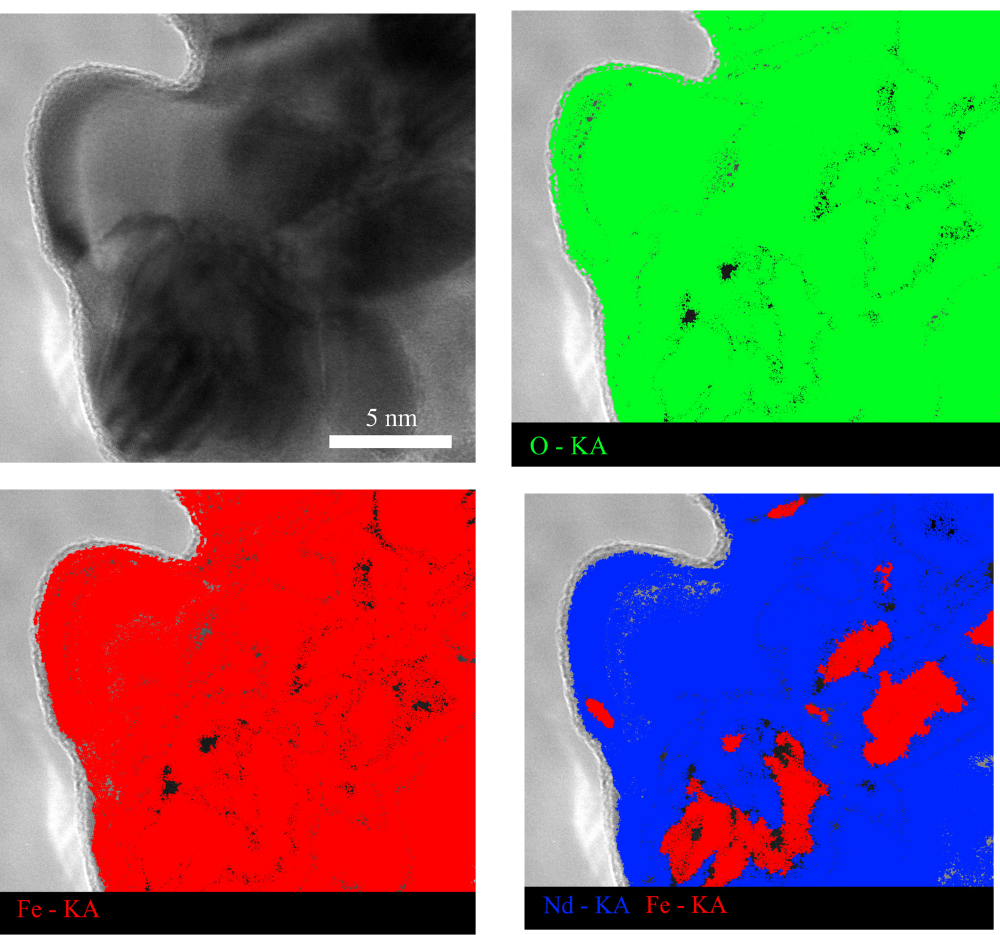
Figure 3. TEM data and energy dispersive analysis of the studied S3 samples.